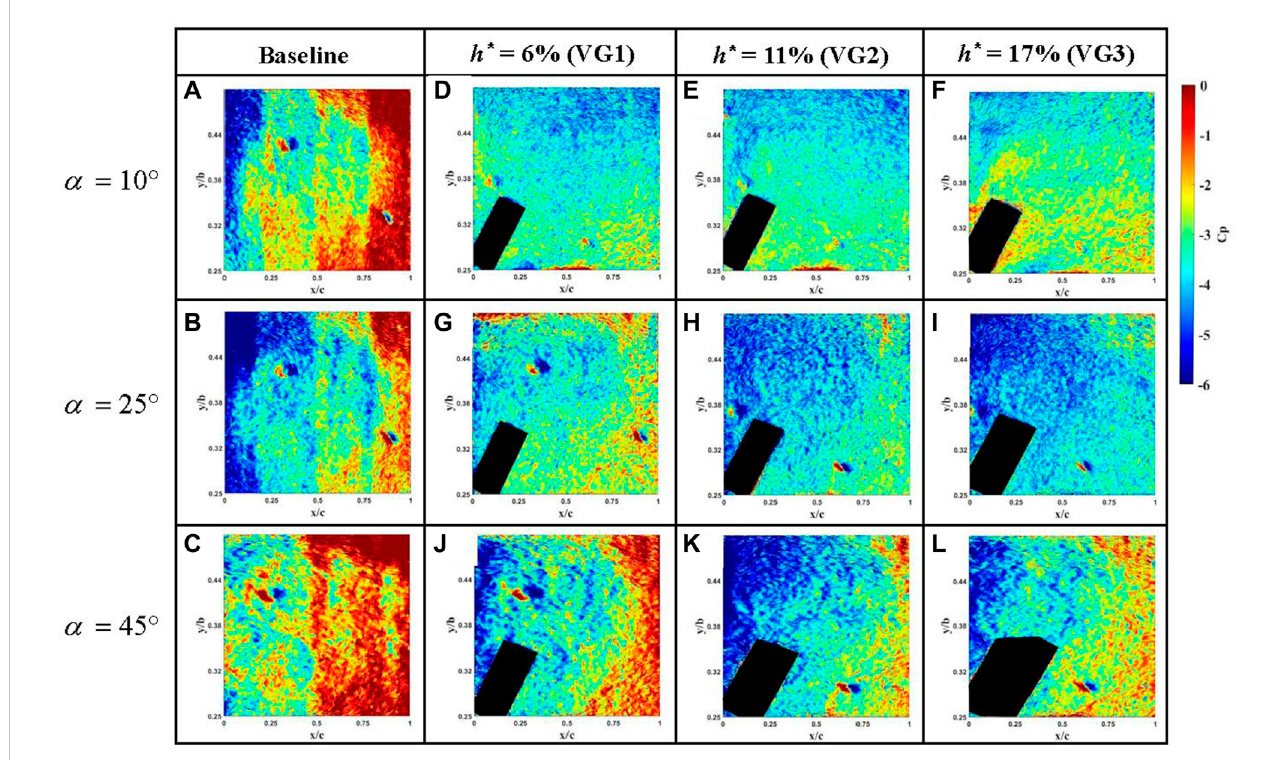
FIGURE 5 Surfacepressuredistributionswith/withoutthealula-likevortexgeneratoratdifferentanglesofattack: (A – C) Withoutthealula-likevortexgenerator,and (D – L) with different thicknesses of the alula-like vortex generators.